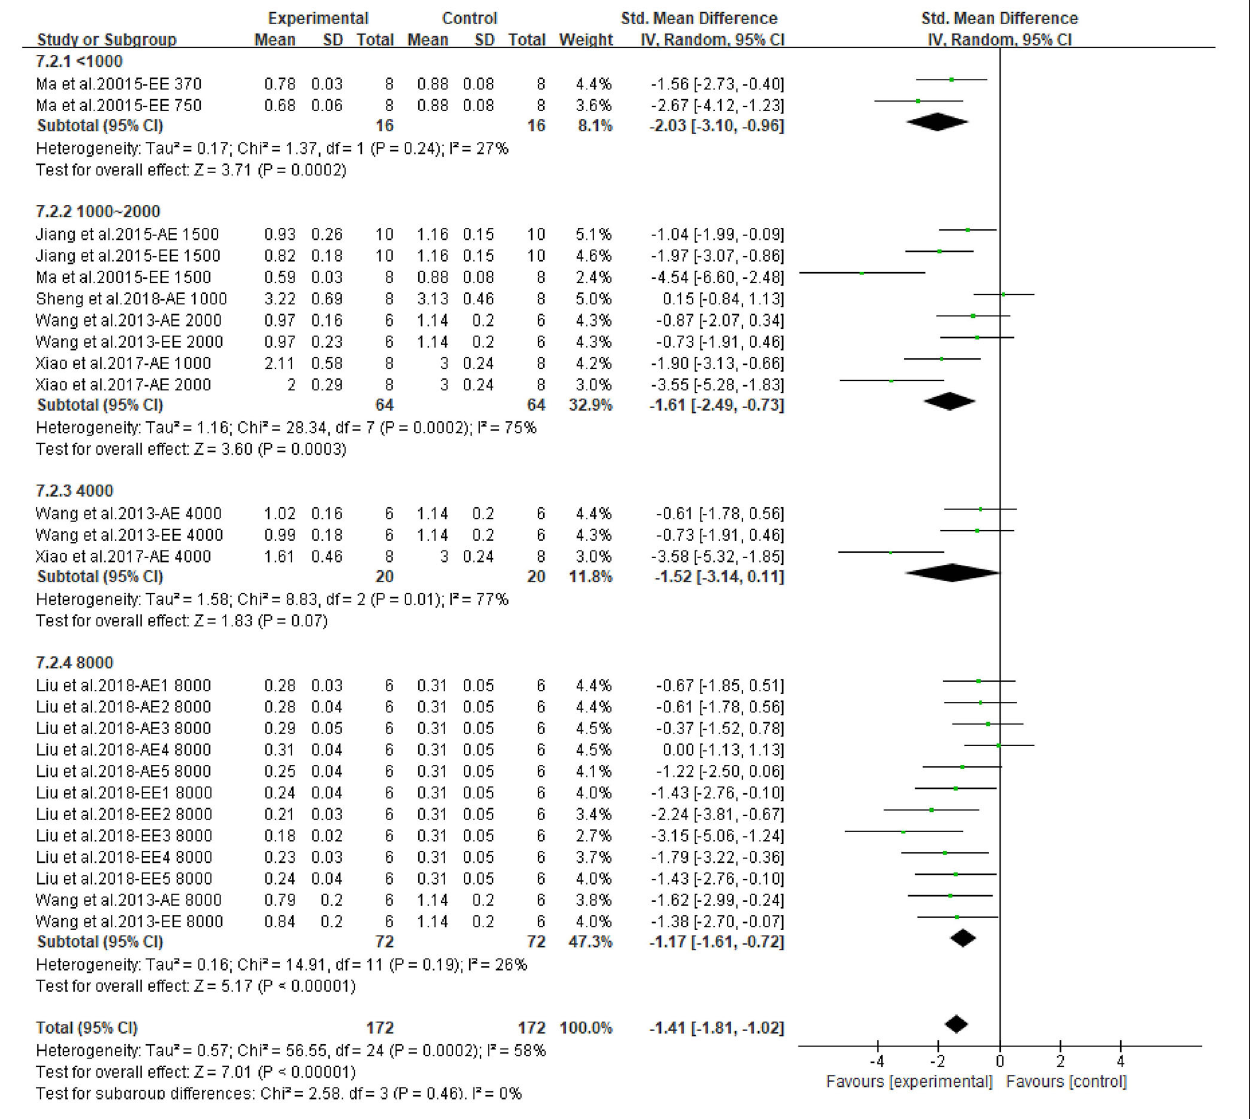
FIGURE 9 | Forest plot for the effect of Cyclocarya paliurus (CP) on low-density lipoprotein levels in animal models. Subgroup analysis was performed according to